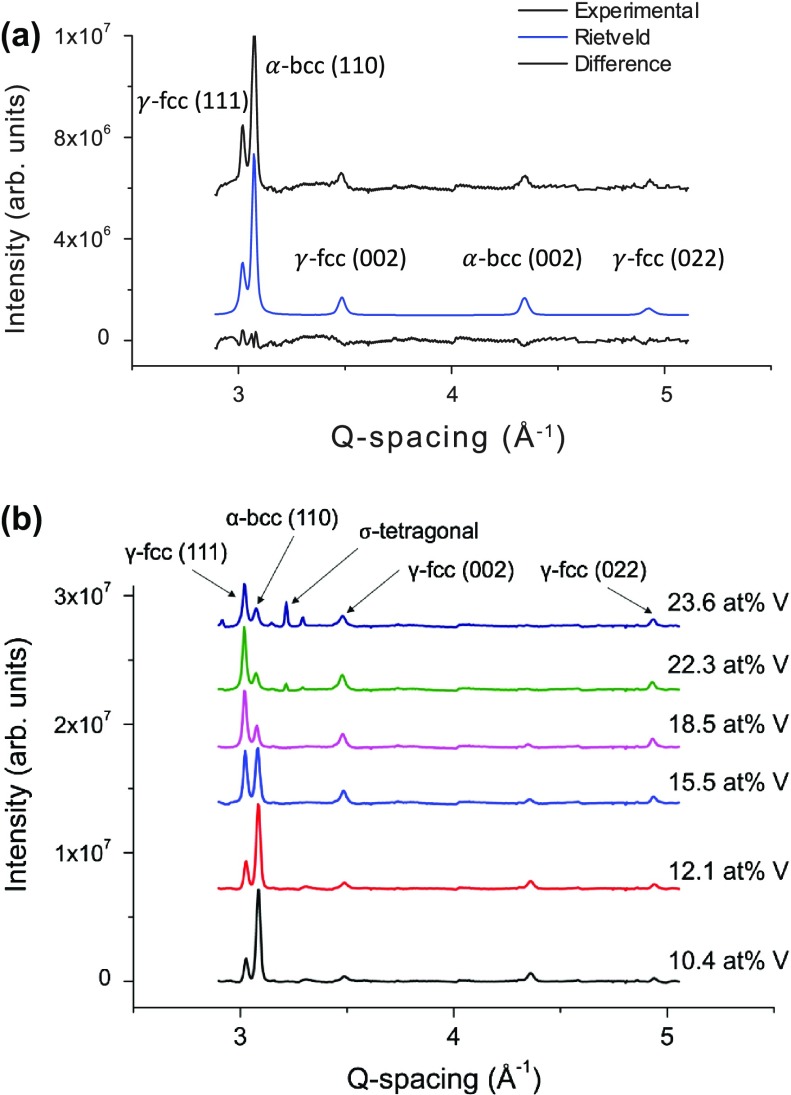
(a) Synchrotron XRD results showing the experimental Rietveld refinement and residuals of an Fe56Co23V11 thin film. Known phases of the α body-centered cubic phase (α-bcc) with a strong (110) preference and the γ face-centered cubic (γ-fcc) phase were identified. (b) XRD patterns of thin Fe-Co-V films with equal atomic concentrations of Fe and Co and varying V content. The clear presence of the σ-tetragonal phase is found above 20 at% V in agreement with bulk phase diagrams.